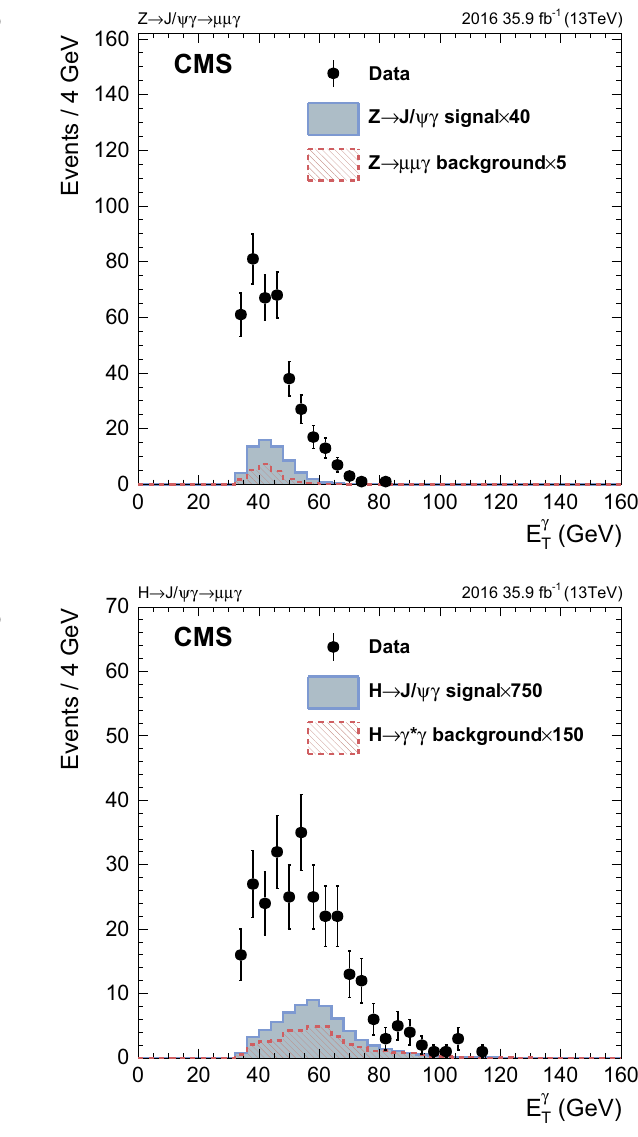
Fig. 5 The photon E T distributions in the Z (upper) and Higgs (lower) boson searches. The number of events in the distributions from signal events is set to factors of 40 and 750 those of the SM predicted yields for the Z and H boson decays, respectively. The number of events in distri- butions in the resonant background samples is normalized to respective factors of 5 and 150 larger than the expected